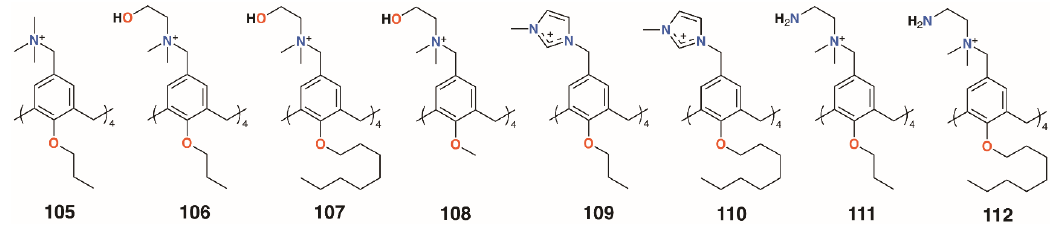
Figure 16. Charged calixarenes reported by Loftsson, Yushchenko, and Melzhyk.